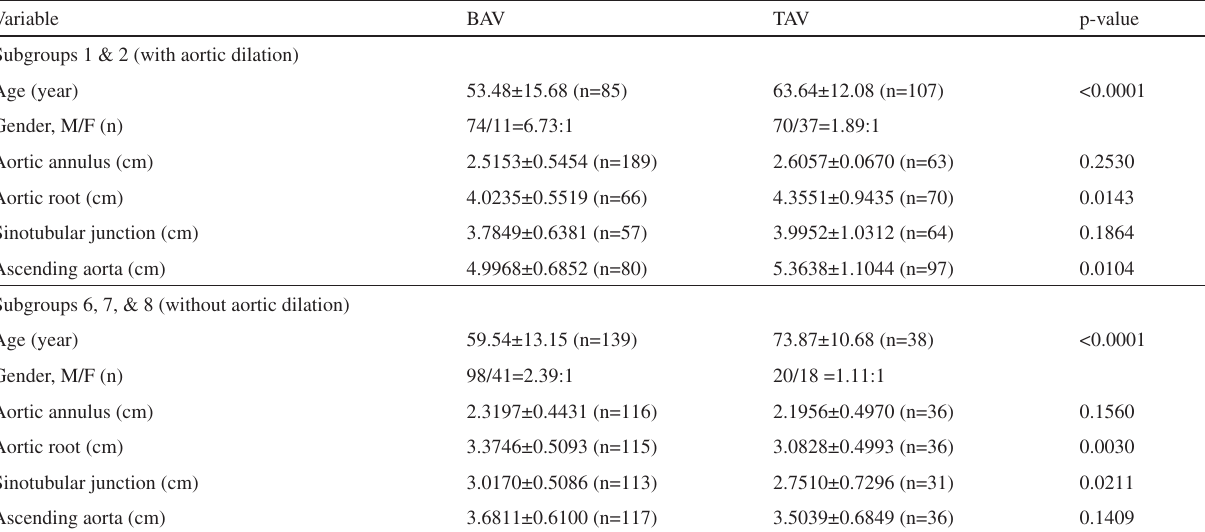
Table 4 - Age, gender, and aortic dimensions of patients with and without aortic dilation.